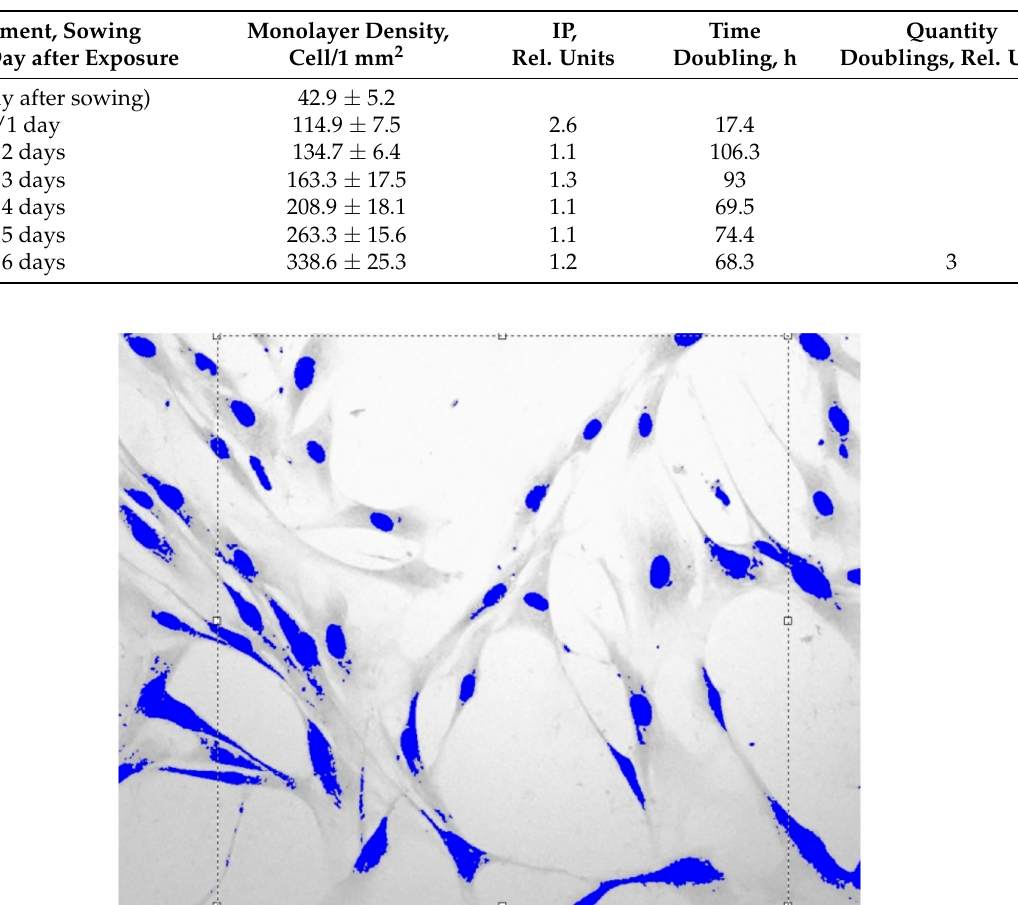
Table 1. Proliferative activity of the culture of dermal fibroblasts (electromagnetic impulse action E = 500 J).